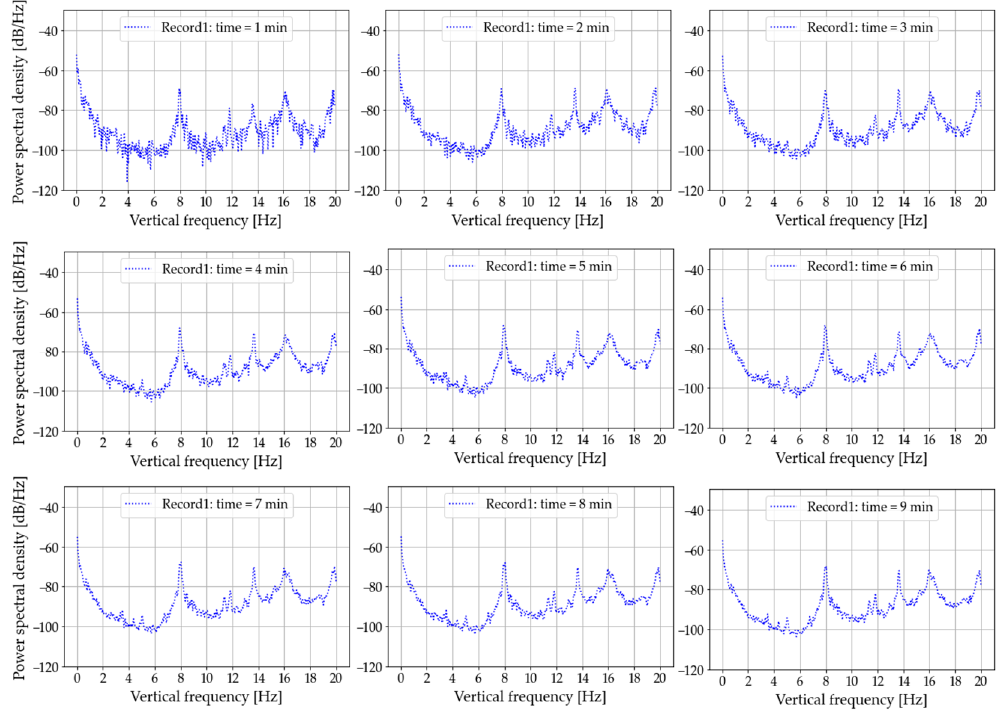
Figure 14. Power spectral density of the first nine vertical frequency observations of the Uninorte bridge.